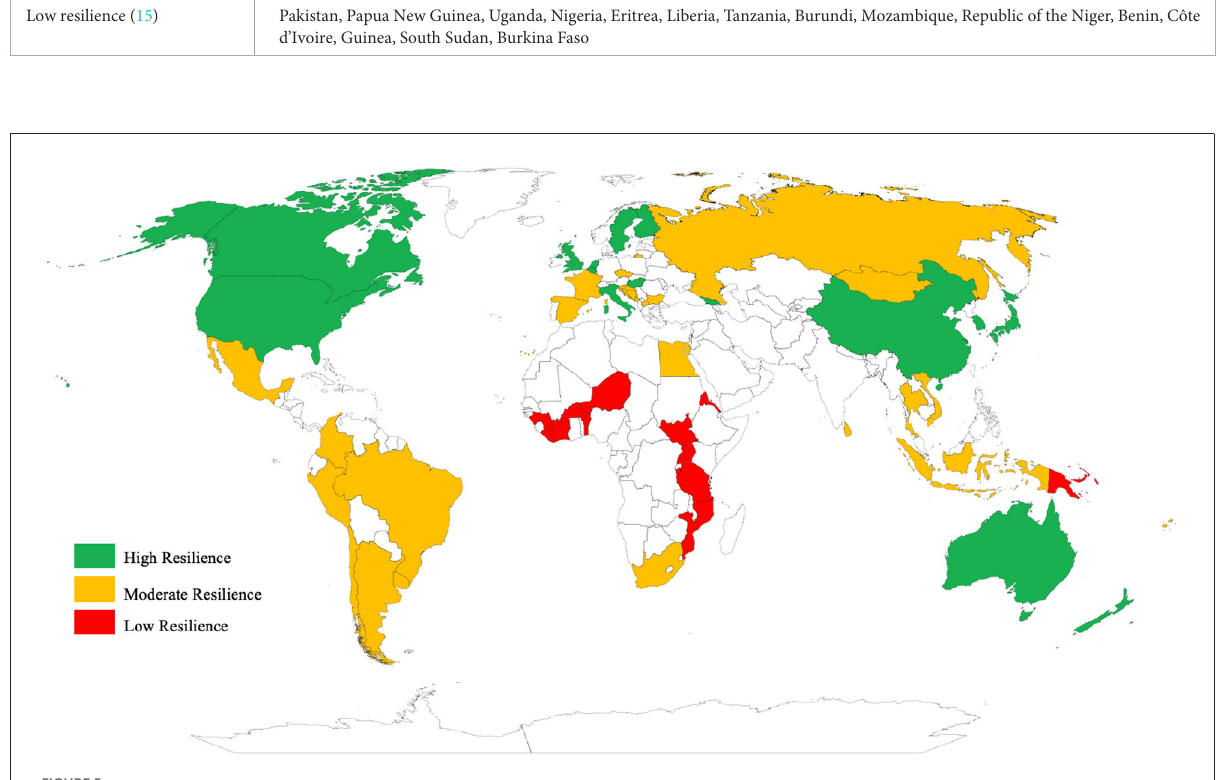
FIGURE5 Global distribution of health system